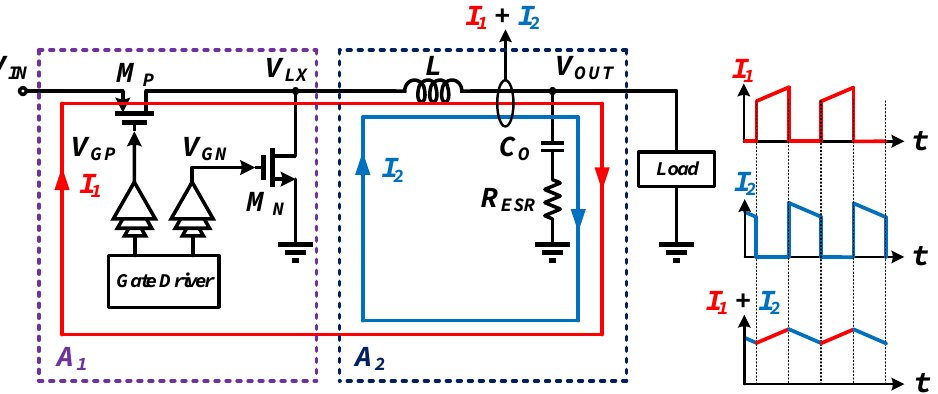
Figure 3. Inductor current distribution of the DC-DC buck converter.